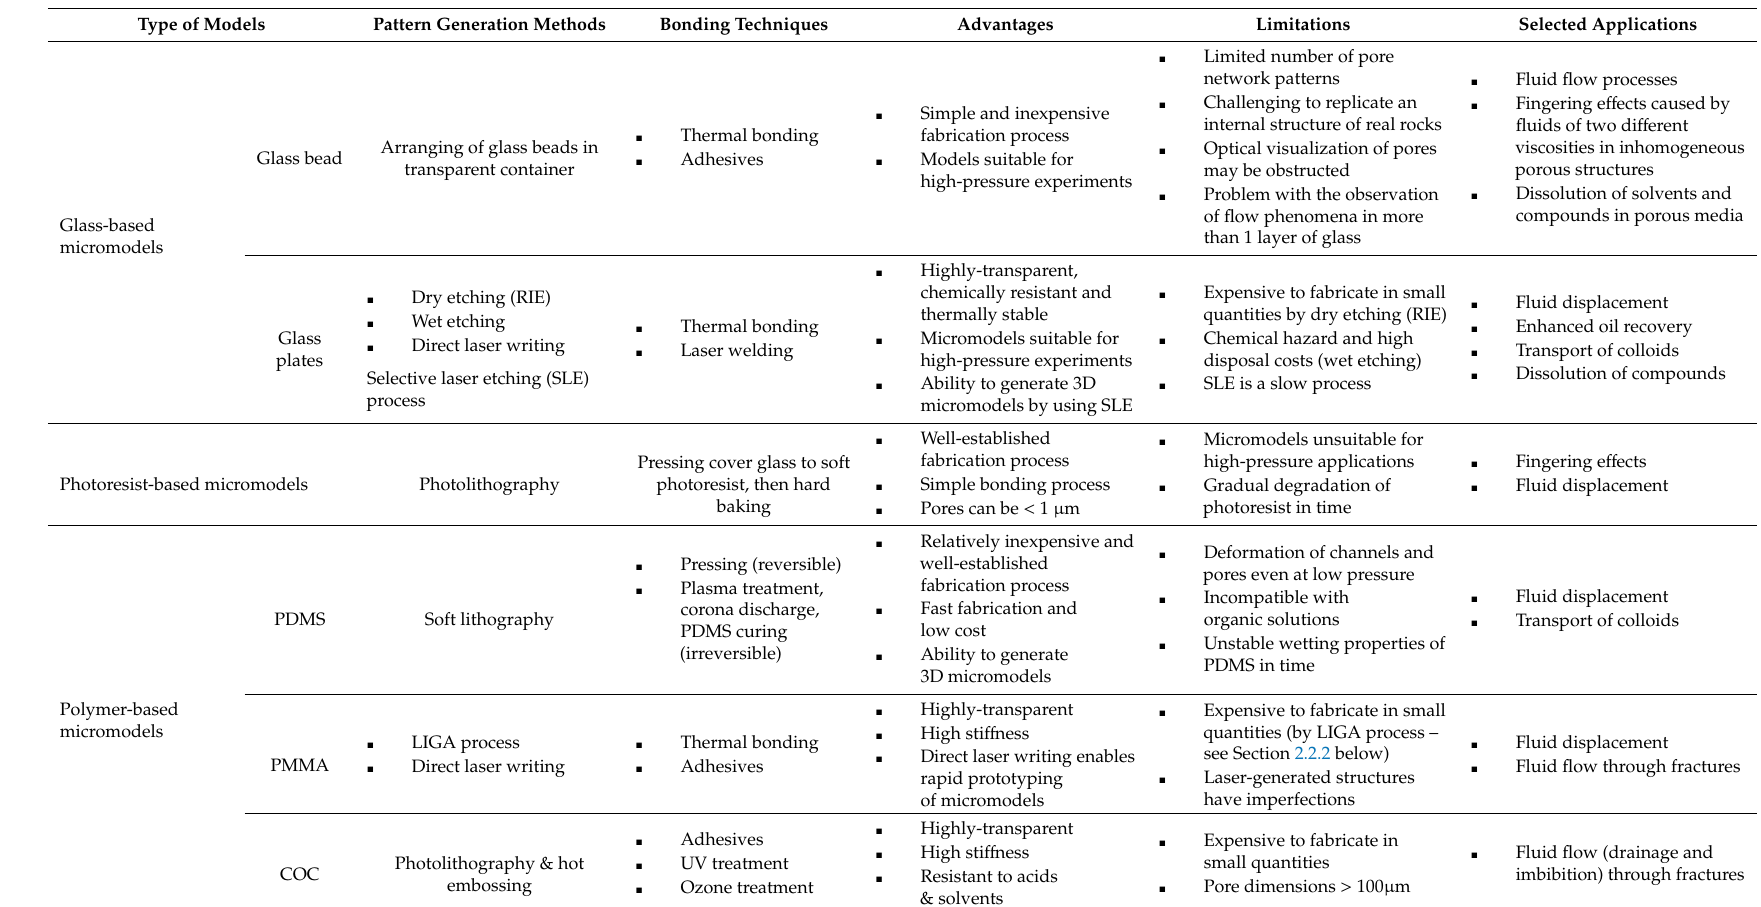
Table 1. Di ff erent types of micromodels reviewed in this